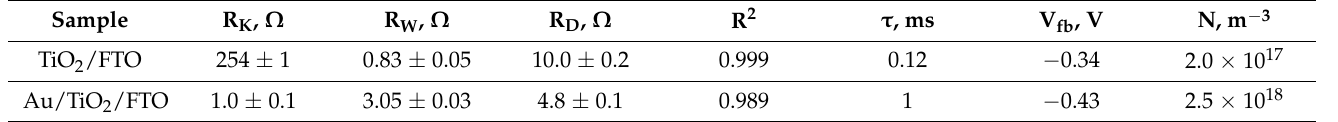
Table 2. Approximation of data obtained using impedance spectroscopy.